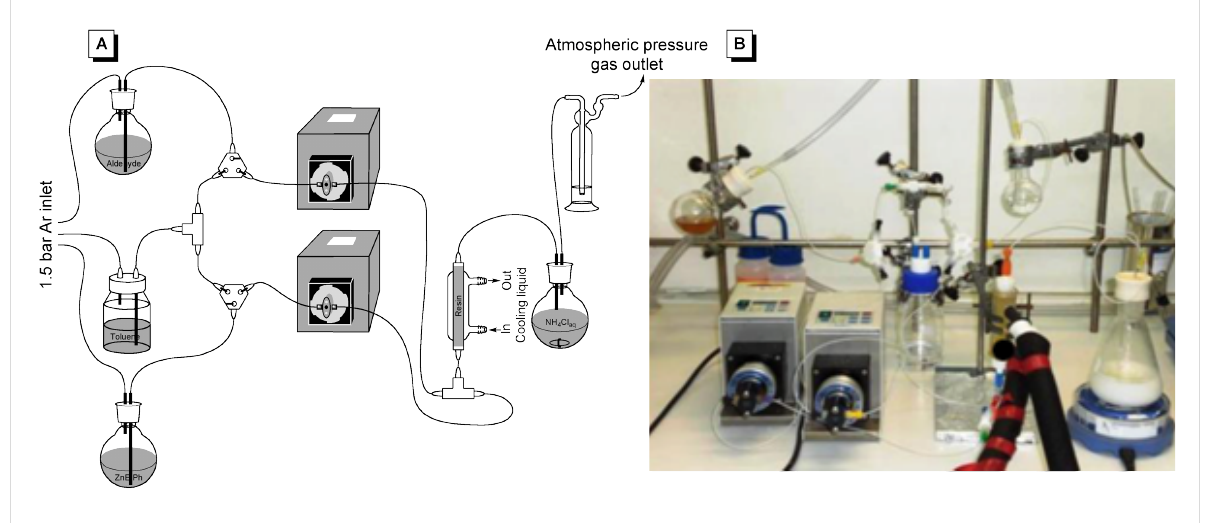
Figure 3: Experimental set-up for the continuous flow experiments. (A) Schematic representation and (B) Actual system.